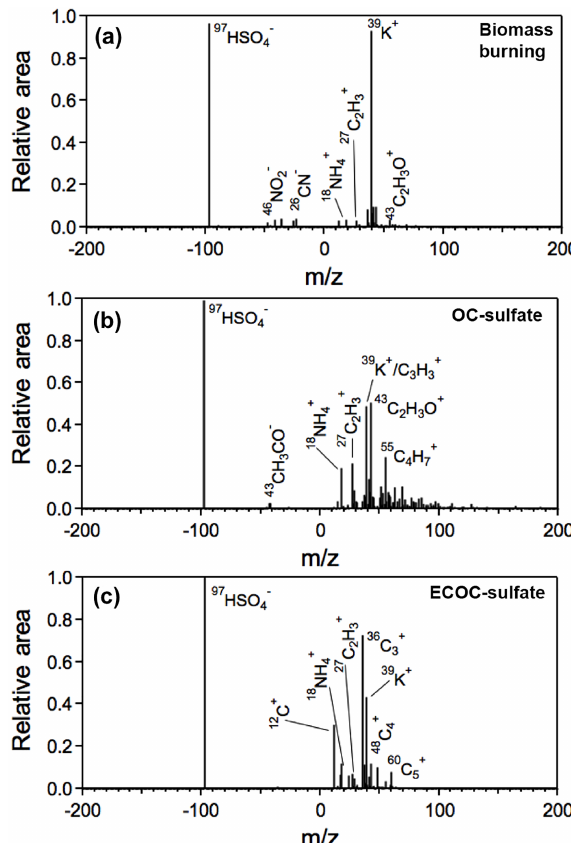
Figure 2. Average positive and negative ion single-particle mass spectra (ATOFMS), with characteristic peaks labeled, for the domi- nant aged combustion particle types observed: (a) biomass burning, (b) OC-sulfate, and (c)